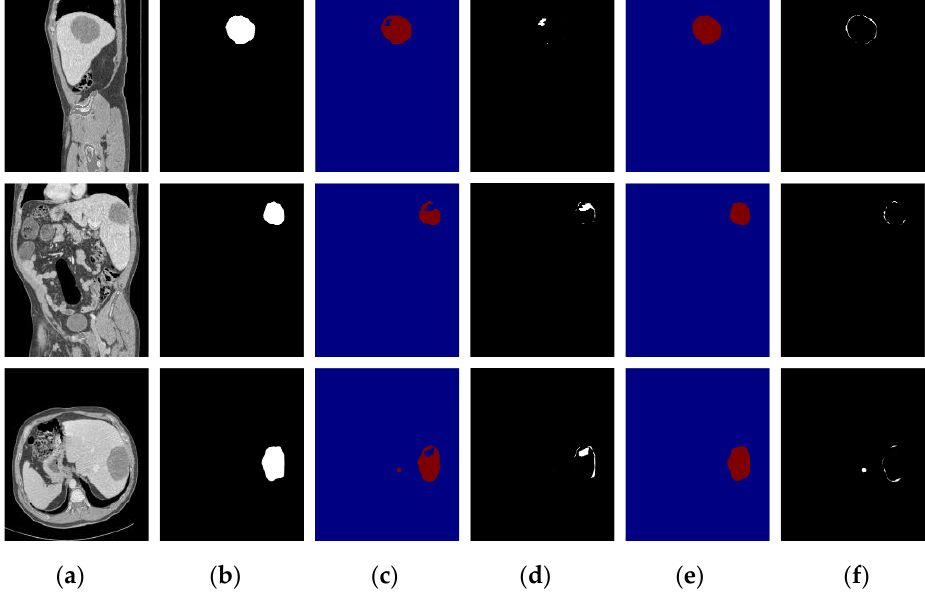
Figure 14. Segmentation result of a large tumor; the first row is the sagittal plane, the second row is the coronal plane, and the third row is the transverse plane. ( a ) CT image; ( b ) Ground truth; ( c ) DenseUNet segmentation results; ( d ) difference image between DenseUnet and ground truth; ( e ) the proposed algorithm’s segmentation results; ( f ) difference image between the proposed algorithm and ground truth.